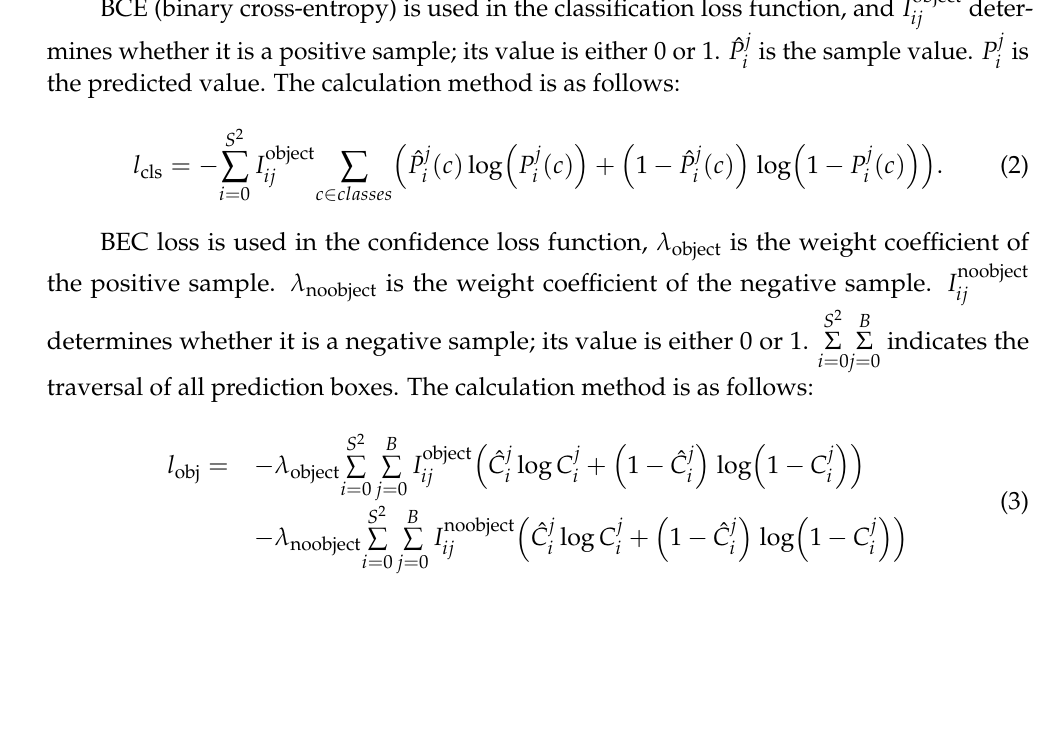
 determines whether it is a negative sample; its value is either 0 or 1. positive sample. noobject